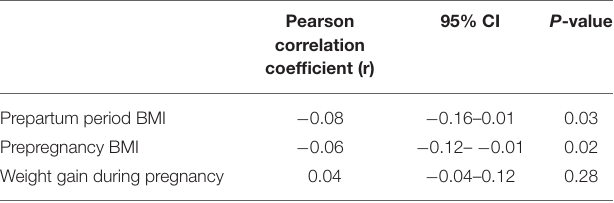
TABLE 4 | Relationships between birth weight and Weight gain during pregnancy, Prepartum period BMI, Prepregnancy BMI in the study subjects ( N = 1,981).